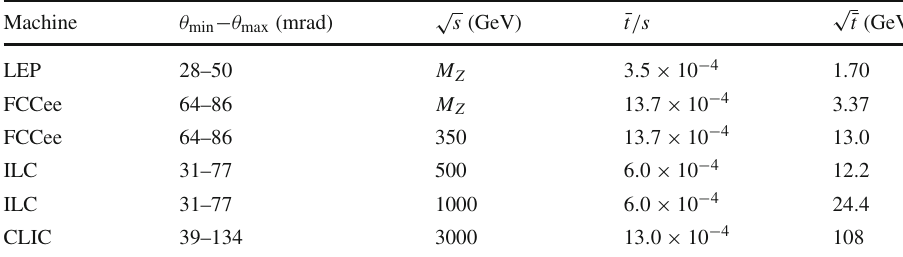
Table 1 Basic parameters of the detectors at e + e − past and future machines. The θ min − θ max are the generic LABH detector acceptances. The ¯ t is defined in